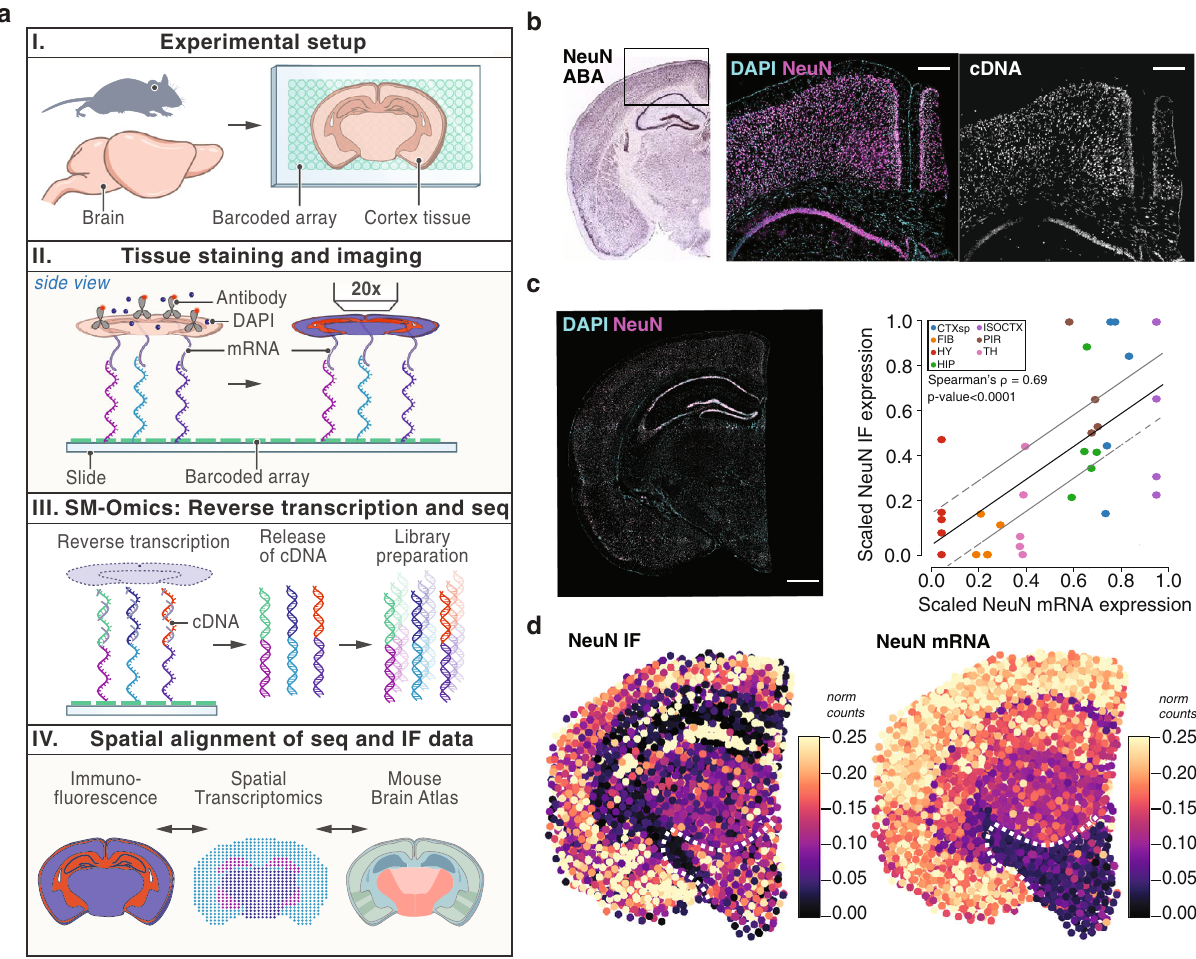
Fig. 3 Spatial RNA-Seq and immuno fl uorescence highlights tissue speci fi c expression patterns in the mouse brain cortex. a Experimental setup. Tissue sections are placed on the spatial array (I), stained for nuclear and corresponding antigen targets, imaged for IF signals (II) and SM-Omics libraries created (III). Spatial gene and antibody expression data are processed and compared to the reference ABA atlas (IV). b Combined antibody IF and spatial transcriptomics in situ measurements. ABA in situ hybridization reference image (left) with NeuN staining neuronal nuclei with marked isocortex area (rectangle). Mouse brain isocortex tissue ( n = 3) stained for DAPI (middle; cyan) and NeuN IF (middle; purple) and corresponding fl uorescent gene activity cDNA footprint (right; white). Scale bar; 200 µ m. c , d Performance of combined antibody IF and spatial transcriptomics measurements. c NeuN immuno fl uorescence (stained tissue section, left; scale bar 800 µ m; and y axis; mean scaled signal, right) and mRNA in situ measurements ( x axis, scaled normalized expression, right) per tissue section ( n = 5, Methods) in each of seven regions (color code) in SM-Omics. Black line: linear regression with respective standard deviations (gray lines). d Antibody IF signals (normalized and scaled expression shown in color scale, NeuN IF; left) and mRNA expression (normalized and scaled expression shown in color scale, NeuN mRNA; right) aggregated in SM-Omics-like spots. White dashed lines: hypothalamus region. Annotated region abbreviations: CTXsp (cortical subplate), FIB ( fi ber tracts), HY (hypothalamus), HIP (hippocampal formation), ISOCTX (isocortex), PIR (piriform areas) and TH